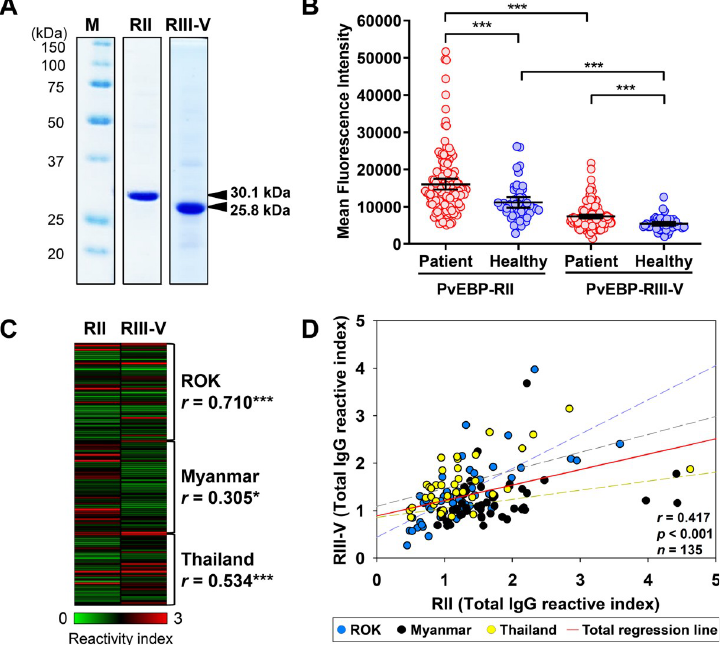
Fig 4. Humoral immune response of PvEBP-RII and PvEBP-RIII-V. (A) Purity confirmation by SDS-PAGE of recombinant PvEBP-RII (30.1 kDa) and PvEBP-RIII-V (25.8 kDa) expression. (B) Total IgG prevalence of each domain with the vivax patient (red dot) and healthy individual (blue dot) sera. The bar indicates the mean fluorescence intensity (MFI) ± 95% CI. The p values were calculated by Student’s t -test. Significant differences are shown as triple asterisks p < 0.001. (C) IgG prevalence visualized for comparison between RII and RIII-V with each patient sera by normalized reactivity index. Significant differences are shown as single asterisks p < 0.05 and triple asterisks p < 0.001. (D) Correlation between RII and RIII-V total IgG reactive indices using Pearson correlation test ( r ). Blue dot and dash line represent patient sera reactive index from ROK and its regression line. Black and yellow dot and dash line represent reactivity indices and its regression lines from Myanmar and Thailand patient sera, respectively. Red line indicates total regression.